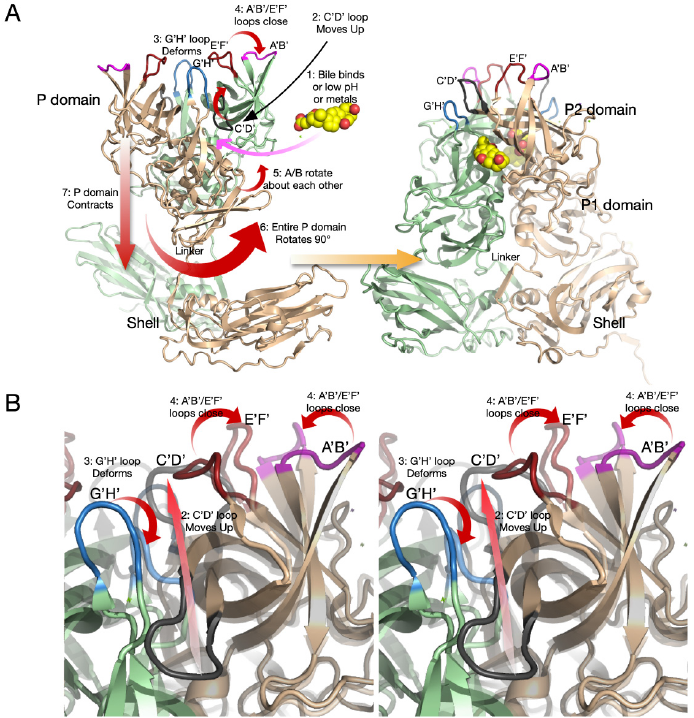
Figure 6. Structural details of the transition from the extended to the contracted MNV-1 states. ( Panel A ) shows the structural changes of the whole P domain transitioning from the extended to contracted structure. ( Panel B ) shows a stereo view of the concomitant conformational changes within the P domain. For clarity, the two panels are presented at different viewing angles. There are likely multiple structural equilibriums at work, and therefore, this figure represents one possible